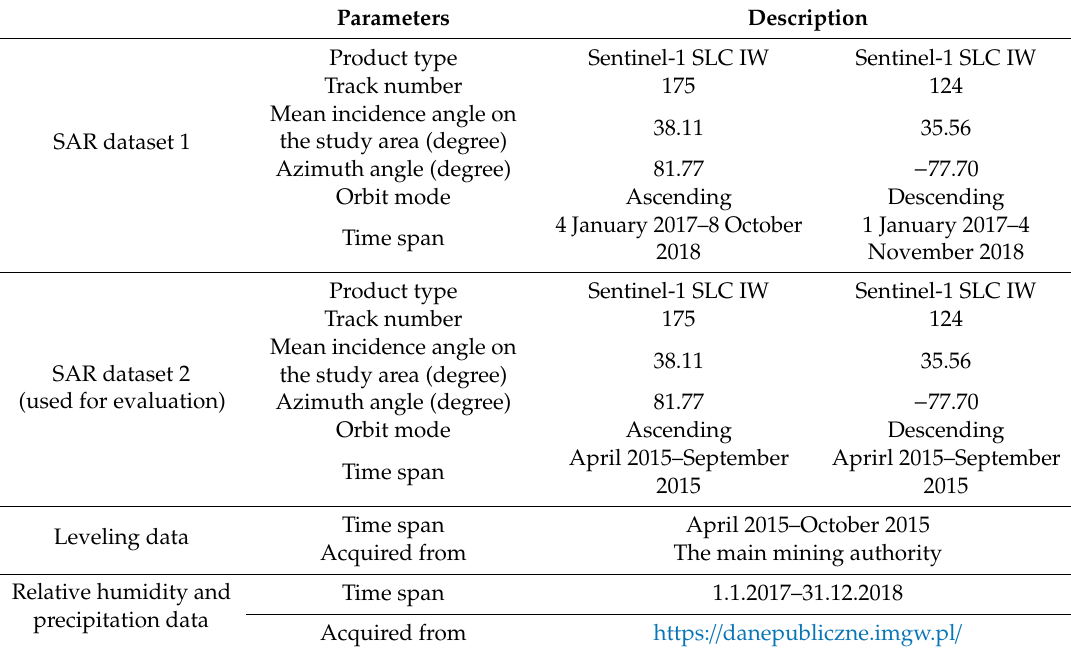
Table 1. Metadata about the data used in the presented